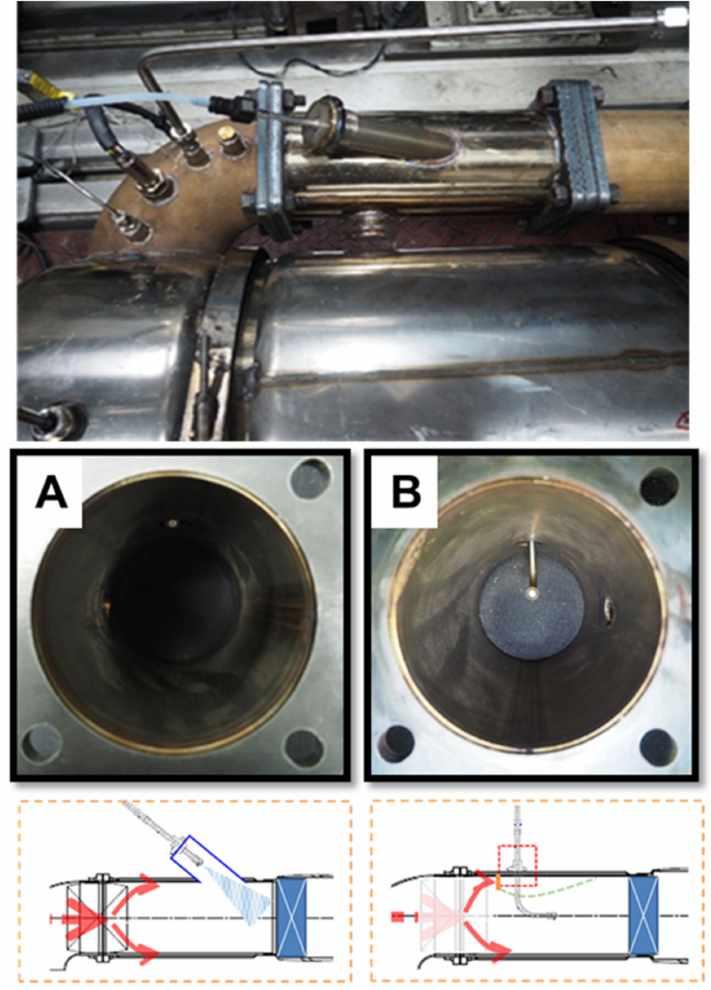
Figure 31. The system’s urea injection models: ( A ) Urea injector model-I (suggested injector) and ( B ) urea injector model L (original model from D6CC diesel engine) adapted from Khristamto et al.